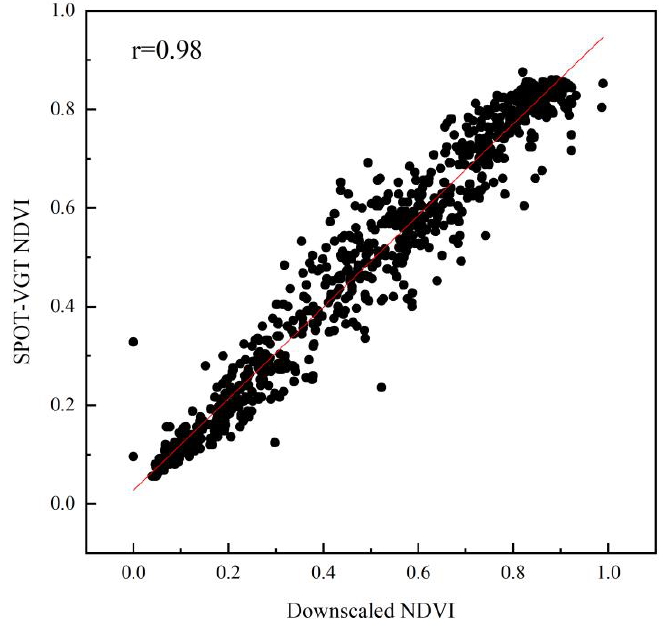
Figure 3. Comparison between the downscaled NDVI and SPOT-VGT NDVI data in 1999 using the Pearson correlation coefficient. Black points are 1000 randomly selected pixels, and the red line is the fitting line. The fitting line equation is y = 0.93x + 0.027, p < 0.05.